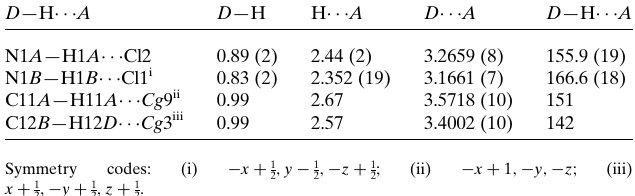
Table 2 Hydrogen-bond geometry (A˚ , (cid:5)